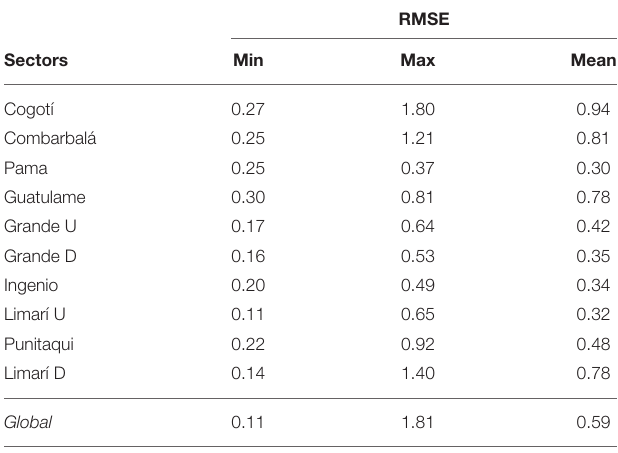
TABLE 2 | Summary statistics of the TEM sounding SCI-FL inversion fit (i.e., root mean squared standardized error; RMSE).